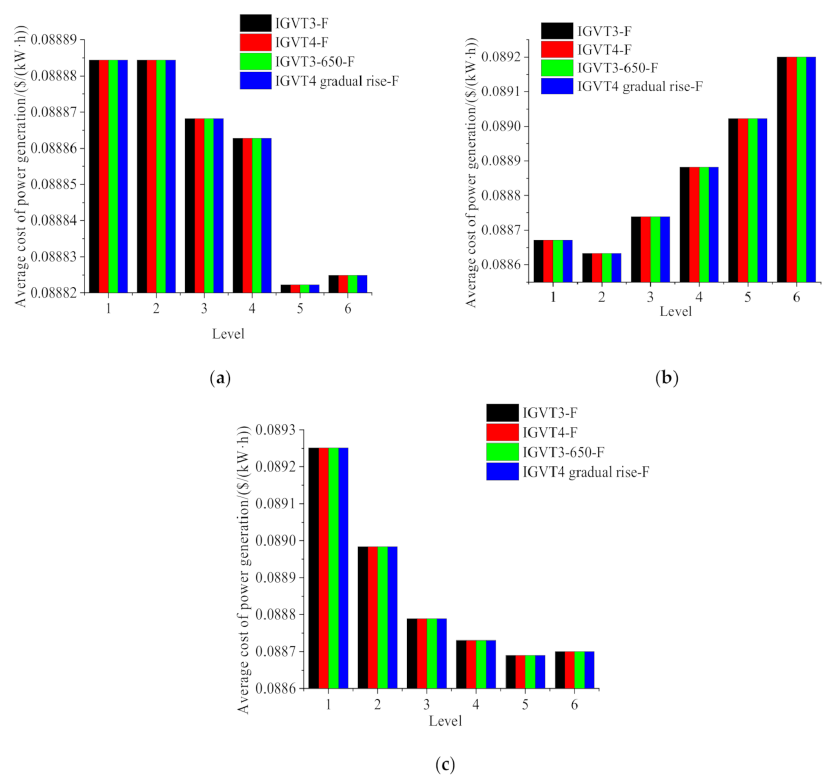
Figure 5. The average power generation cost under all levels (GT 100% load rate). ( a ) LP ( b ) IP ( c ) HP.